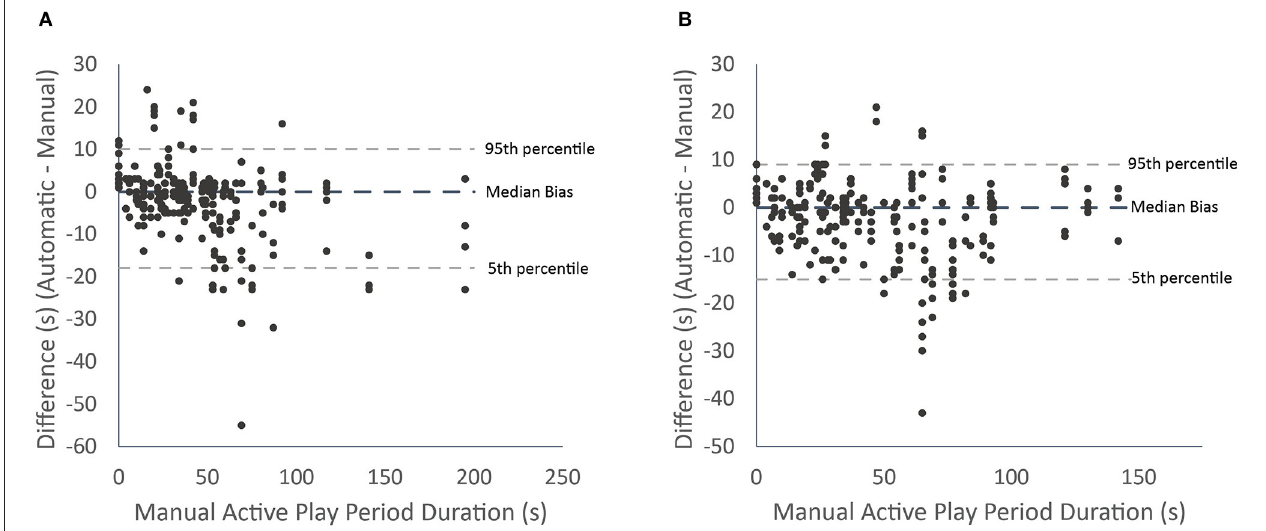
FIGURE 3 | Differences in live play period durations between the automatic and manual methods for each active play period with median bias and 5th and 95th percentiles for the men’s (A) and women’s (B) team.